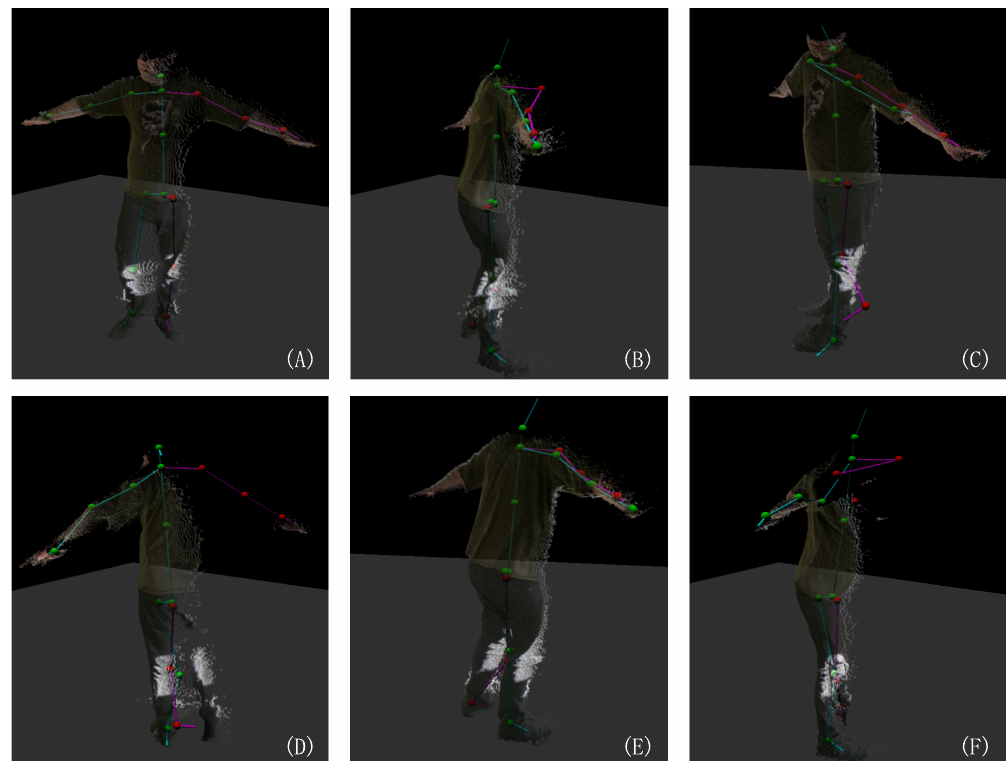
Figure 19. The skeleton observed by Kinect SDK [1] colored in pink and green indicates the left and right side of the body skeleton. It shows that the skeleton observed by the Kinect SDK [1] sometimes (partially) flips when the actor performs a turn-around movement. ( A ) A normal skeleton: pink indicates left, and green indicates right. ( D ) A flipped frame where the right skeleton part is mapped to the left body part and vice versa. ( B , C , E ) Partial flipped frames in which the skeleton of the left and right arms are mapped in the same direction. ( F ) A failure